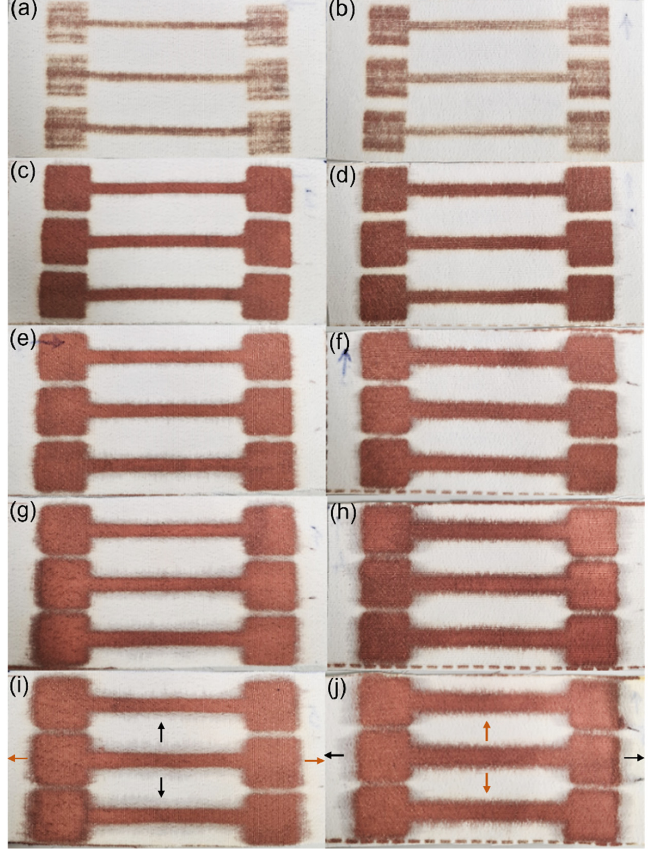
Figure 5. Photograph images of the metallised textiles printed with the Cu–Ag NP catalyst in the warp direction at: ( a ) 1; ( c ) 2; ( e ) 3; ( g ) 4; and ( i ) 5 cycles; and in the weft direction at ( b ) 1; ( d ) 2; ( f ) 3; ( h ) 4; and ( j ) 5 cycles.